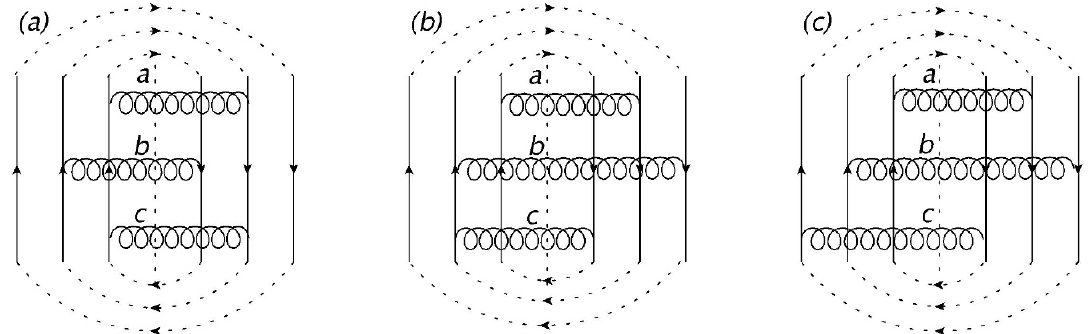
Figure 11 . Examples for diagrammatic contributions with 3 o(cid:11)-diagonal gluons that link between one (a), two (b) and three (c) di(cid:11)erent pairs of sources. Contributions of type (b) vanish while contributions of type (a) and (c) have color traces that di(cid:11)er by a factor ( N 2 more